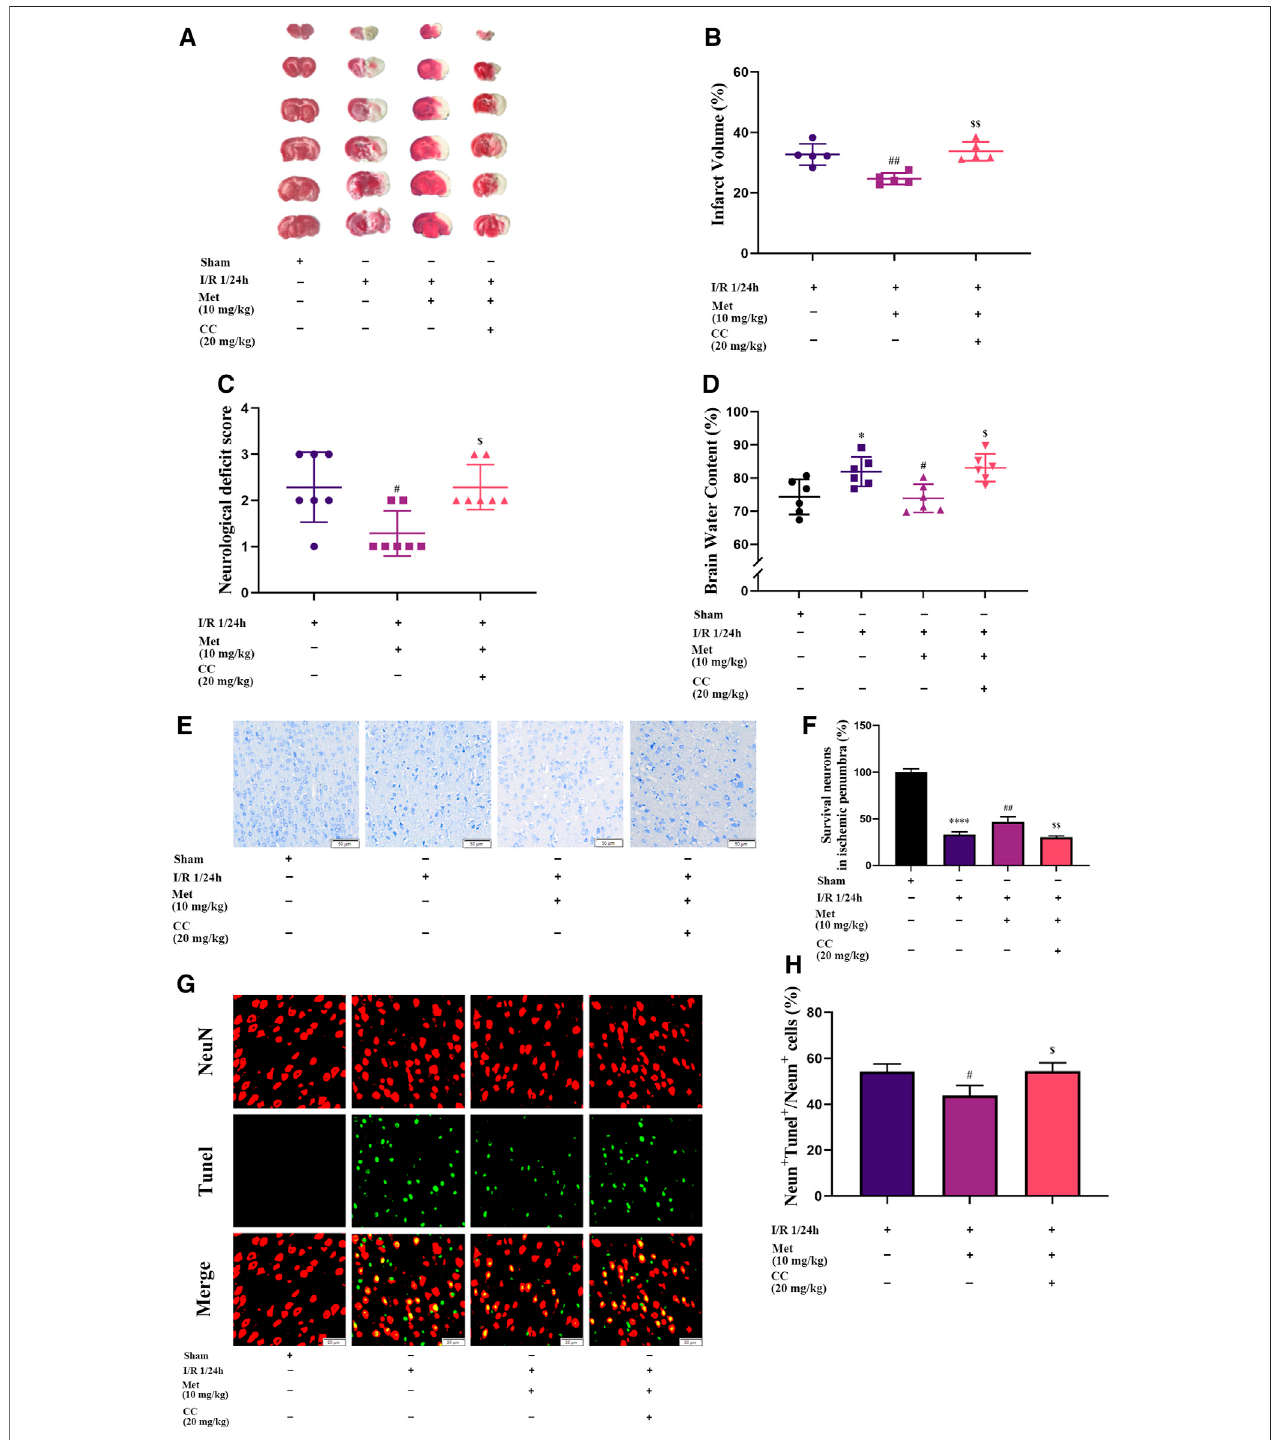
FIGURE 2 | Metformin alleviates cerebral edema, reduces cerebral infarct volume, improves the neurological de fi cit score, and ameliorates neuronal apoptosis in the ischemic penumbra. However, Compound C signi fi cantly reduces the above-mentioned effects of metformin. (A,B) Cerebral infarct volume was assessed by TTC staining ( n = 5). (C) The neurological de fi cit score was assessed by the Zea-Longa fi ve-point scoring system ( n = 7). (D) Brain edema was evaluated by measuring the brain water content ( n = 6). (E – H) Survival and apoptosis of neurons around the ischemic penumbra were evaluated by Nissl staining ( n = 3, bar = 50 μ m) and TUNEL staining ( n = 3, bar = 20 μ m), respectively. (* p < 0.05, **** p < 0.0001 vs. sham; # p < 0.05, ## p < 0.01 vs. I/R 1/24 h; $ p < 0.05, $$ p < 0.01, vs. I/R 1/24 h + Met).